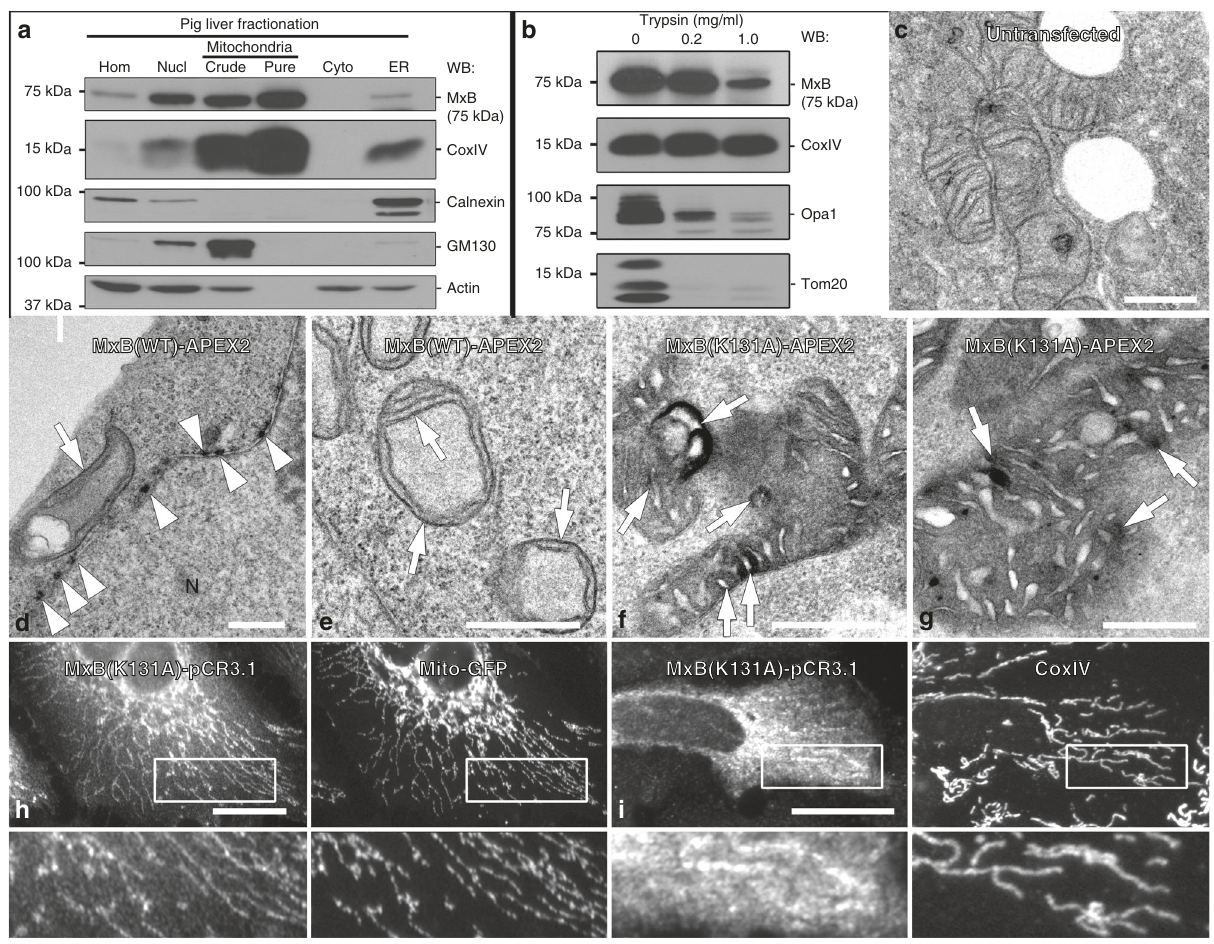
Fig. 4 MxB resides within the mitochondrial matrix and is essential for normal mitochondrial function. a Western blot analysis of MxB distribution observed by subsequent steps of biochemical mitochondrial enrichment from pig liver. Fractions include: homogenate (Hom), a nuclear pellet (Nucl), a crude mitochondria fraction (Crude), a pure mitochondria fraction (pure), a cytosolic fraction (Cyto), and the endoplasmic reticulum (ER); all fractions were probed with marker antibodies to the mitochondria (CoxIV), actin, endoplasmic reticulum (Calnexin), and Golgi (GM130). Equal protein loads were used for each lane. b Western blot analysis of a mitochondria protease protection assay. A freshly isolated, enriched, mitochondria fraction from pig livers was treated with 0, 0.2, or 1 mg ml − 1 of trypsin for 20 min, then probed with antibodies to MxB, or the mitochondrial proteins OPA1, Tom20, and CoxIV. MxB and respiratory complex enzyme CoxIV appear resistant to the higher levels (1.0 mg ml − 1 ) of trypsin, whereas Tom20 and OPA1 are digested.